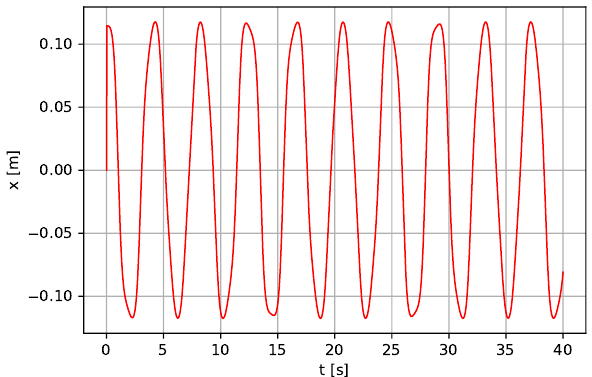
Figure 2. Linear displacement of the Piston in Equation